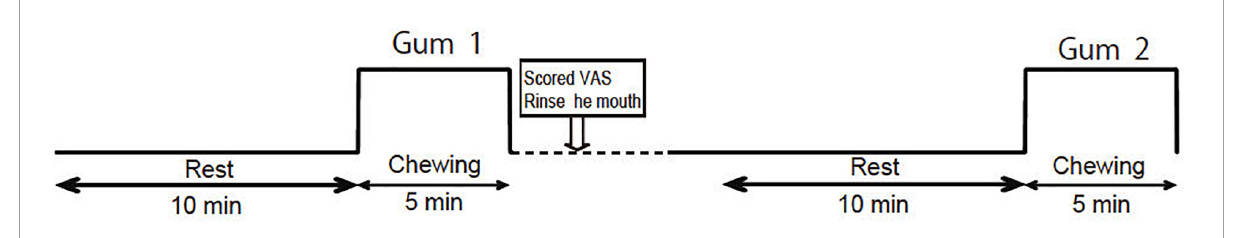
FIGURE1 Experimental protocol. The order of the palatable gum and unpalatable gum (corresponding to Gum 1 or Gum 2) was random.